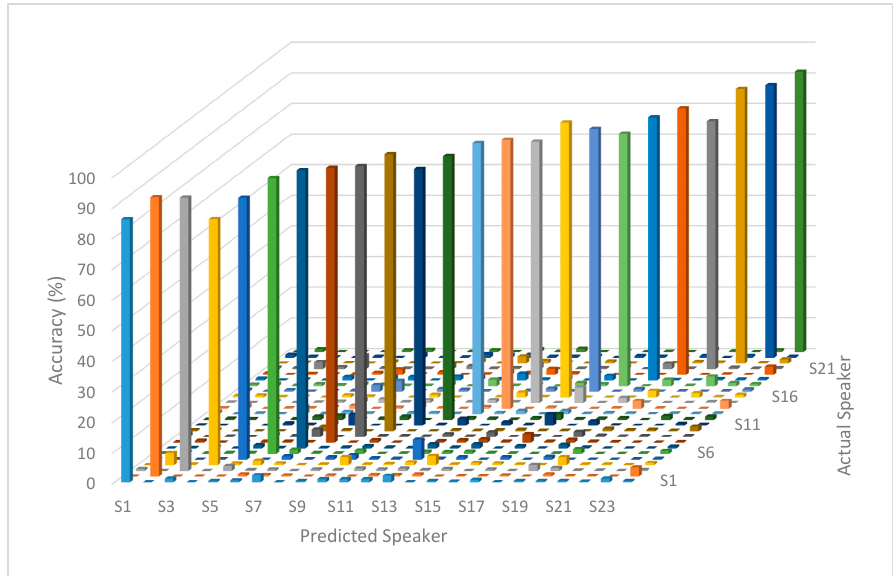
Figure 6. Learning curves for the accuracy and loss of the model for the training and validation set.